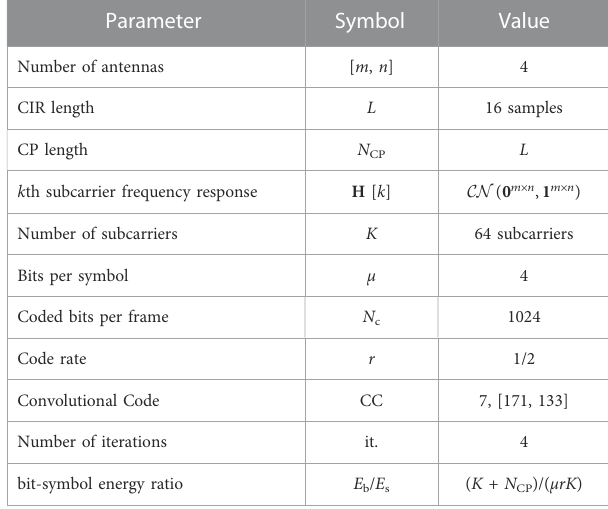
TABLE 6 Supplementary parameters for the iterative detection